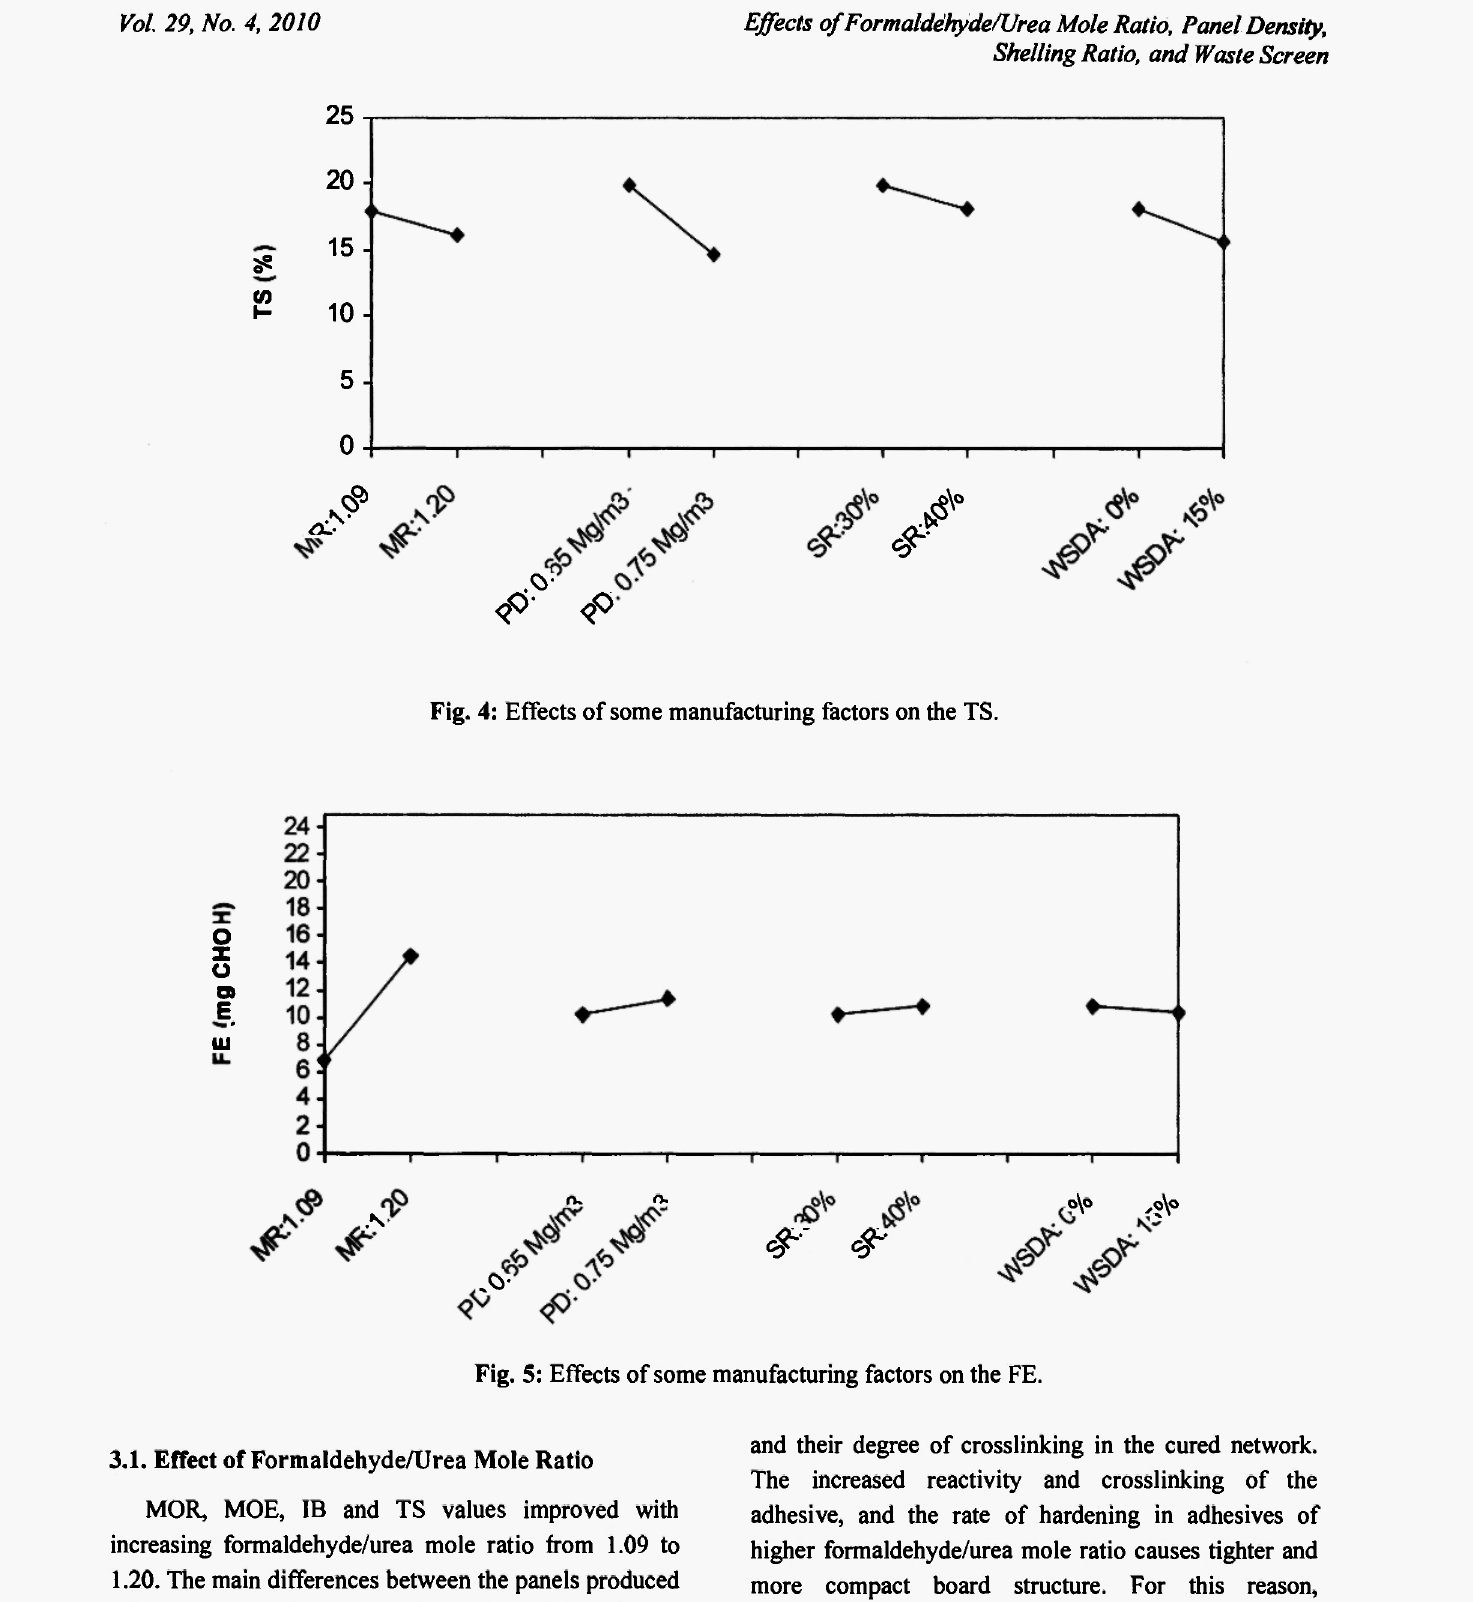
Fig. 5: Effects of some manufacturing factors on the